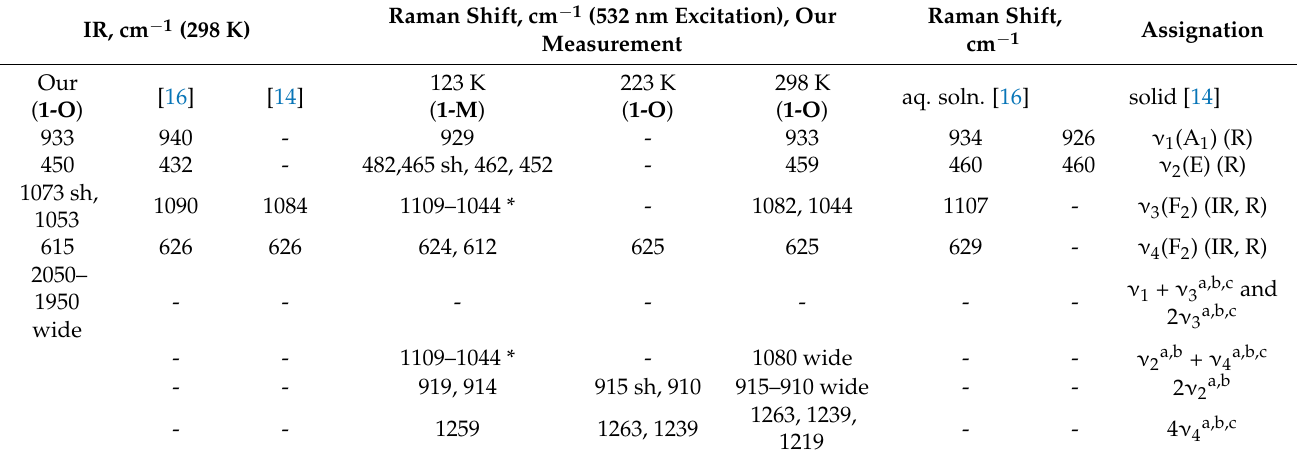
We recorded the Raman spectra at three different temperatures (123, 223, and 298 K) to study the effect of temperature and phase transformation on the numerical value/splitting of Raman shifts of 1-O (298 and 223 K) and 1-M (123 K). The spectra in the Cl–O stretch- ing/bending modes range (1200–300 cm − 1 ) can be seen in Figure 6. At room temperature and at 223 K, the Raman spectra of 1-O show a similar pattern. There is no pronounced splitting of bands, but a shoulder evolves into a band at 910 cm − 1 , on the right at the bottom of the very intensive ν 1 (A 1 ) Raman band (933 cm − 1 and 929 cm − 1 for 1-O and 1-M , respectively). This small intensity band (shoulder) might be the first overtone of − O) (E)(457 cm − 1 at 223 K). This overtone is a wideband system that may contain ν 2 (Cl several components for 1-O and a band consisting of two components for 1-M. It is also plausible that isotopomers ( 35 Cl and 37 Cl) may also contribute to this band [22]. Overtones of 2 δ as (ClO)(F 2 )(A g , B g ) for 1-M appears together with band(s) of δ s